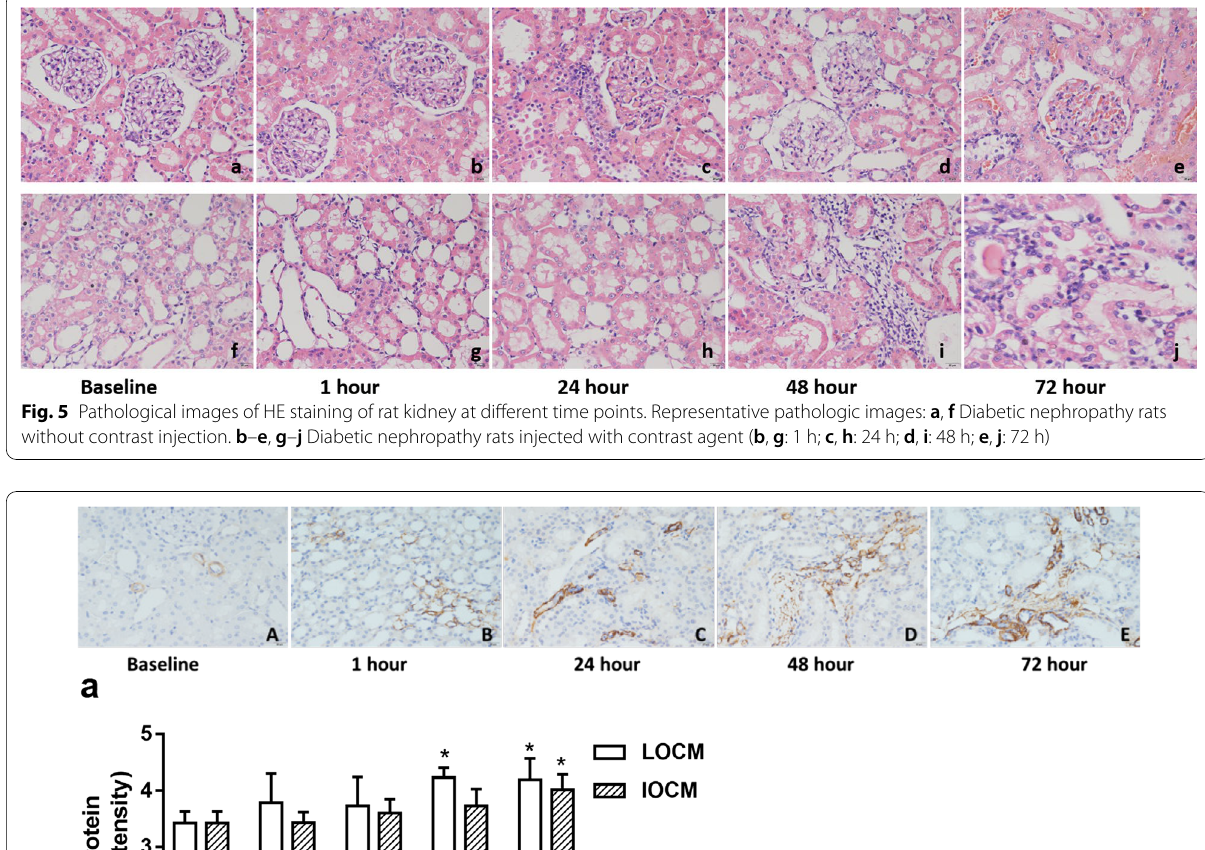
Table 3 Blood biochemical examinations of DN rats in two groups